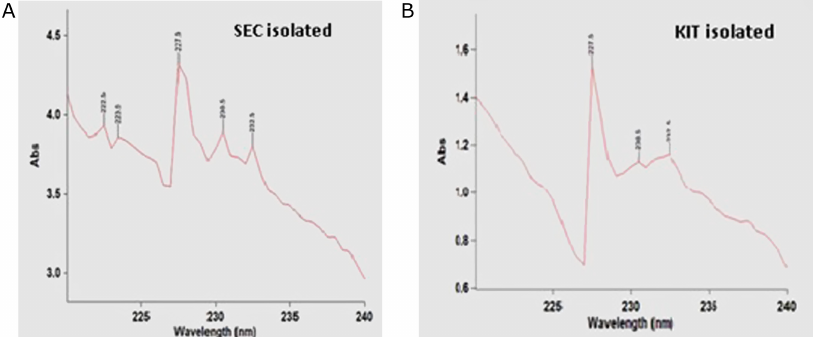
Figure 1. UV-Vis spectrophotometer results for (A) the SEC-isolated and (B) kit-isolated exosome-like nanoparticles of roasted ground